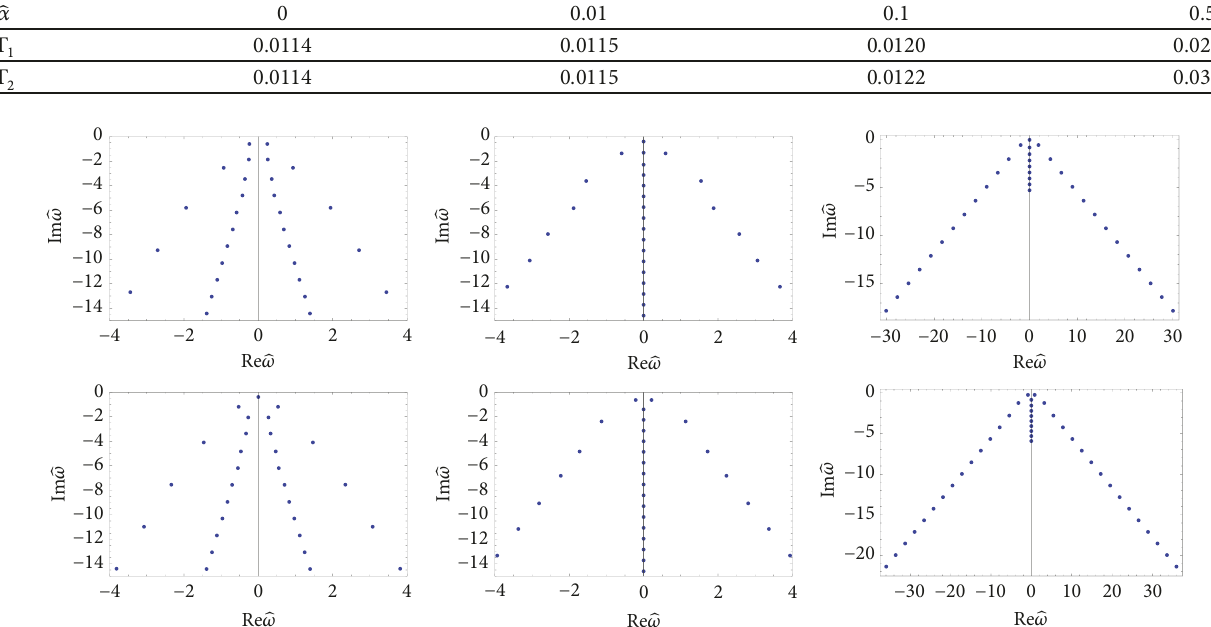
Figure 9: QNMs (blue spots) of the gauge mode for ̂𝛼 = 2 . The first, second, and third columns are for 𝛾 1 = 0.02 , −0.02 , and −1 , respectively. The panels above are for the gauge mode, while the ones below are for the dual gauge mode.